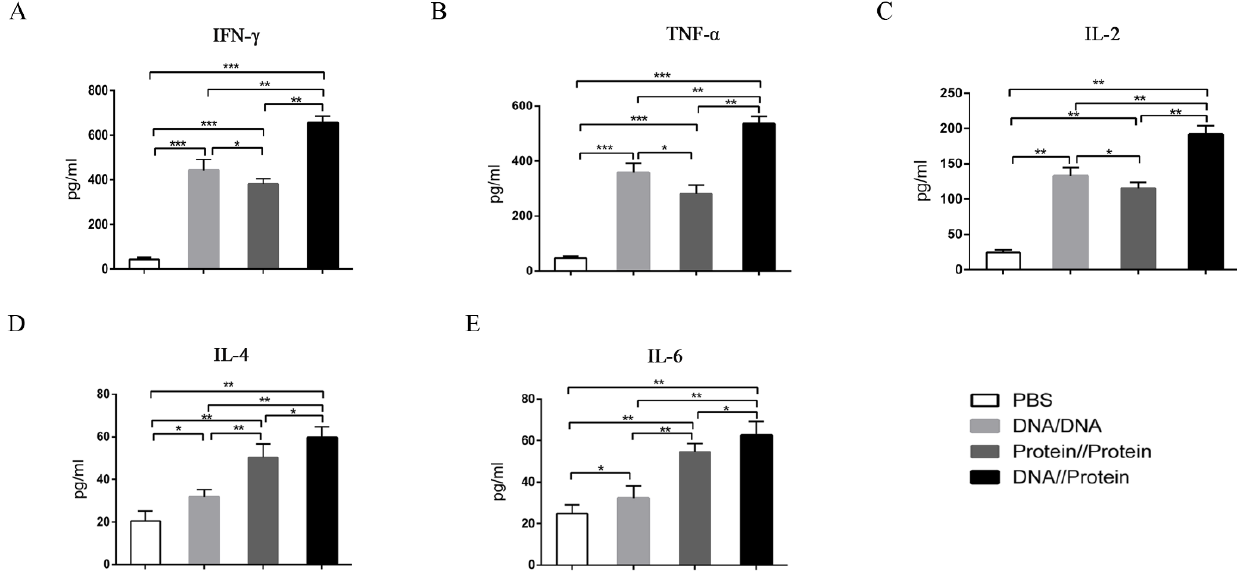
Figure 5. Splenic lymphocyte proliferation reaction of mice in each group two weeks after enhanced immunization. Splenocytes were isolated 14 days after the boost immunization and stimulated with B2L and cF1L proteins. Lymphocyte proliferation response was measured and expressed as the stimulation index (SI). Stimulation index SI = OD experimental group-OD background /OD negative control group-OD background. Each group of data is expressed as mean ± standard error ( n = 5), ** p < 0.01.